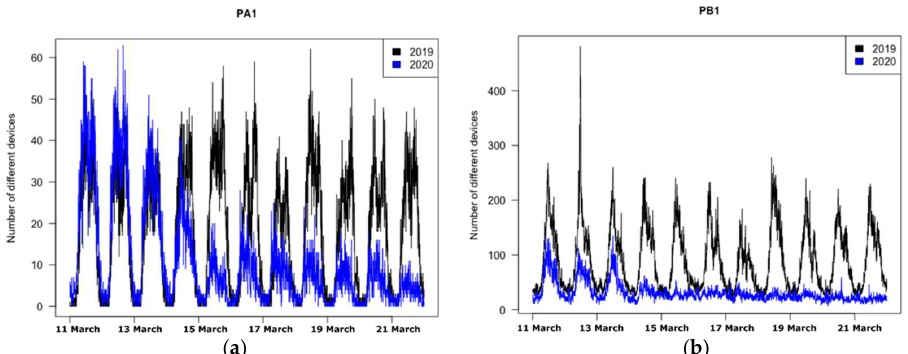
Figure 7. Time evolution of the number of devices, in 2019 and 2020, in sampling zones ( a ) PA1 and ( b ) PB1, during the week that included the start date of the lockdown in Spain (14 March 2020). The percentage decrease in mobility was between 60% and 80% throughout the city.